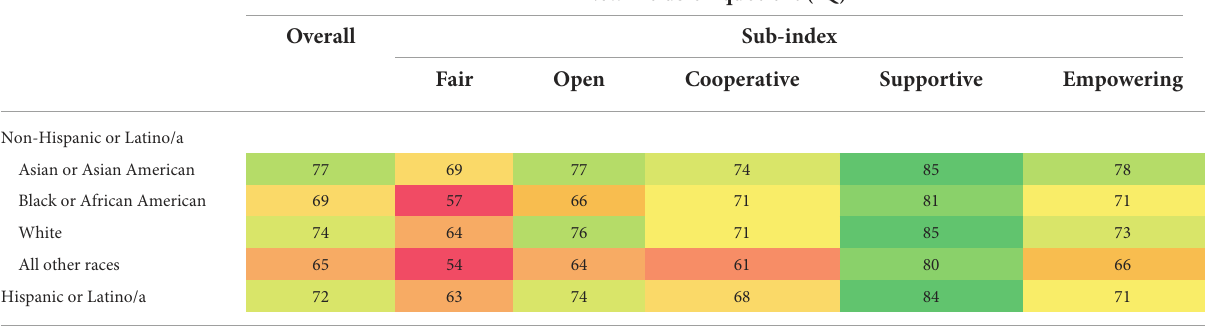
TABLE 4 Heat map of the average percent agreement for the New Inclusion Quotient (IQ) index and sub-indices from the 2019 NIH Federal Employee Viewpoint Survey by race and ethnicity. New inclusion quotient (IQ) Overall Sub-index Fair Open Cooperative